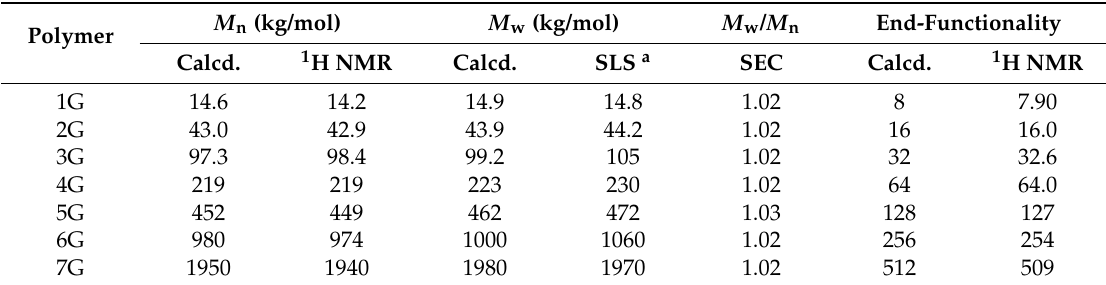
Table 4. Characterization results of the DHB (PMMA)s (1G–7G).